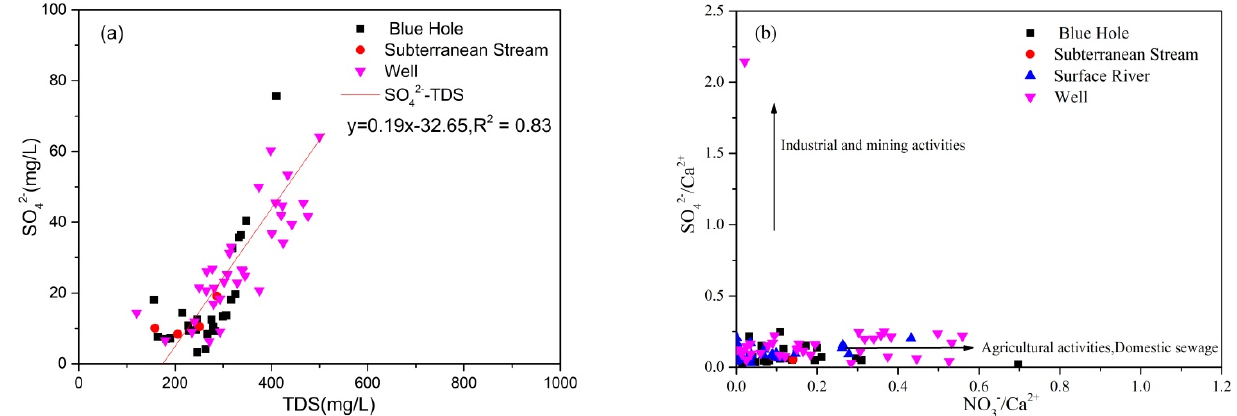
Figure 11. Major ionic ratios within the karst groundwater of the Huixian karst wetland. ( a ) Total dissolved solids (TDS) vs. SO 42 − , ( b ) NO 3 − /Ca 2+ vs. SO 42 − /Ca 2+ .